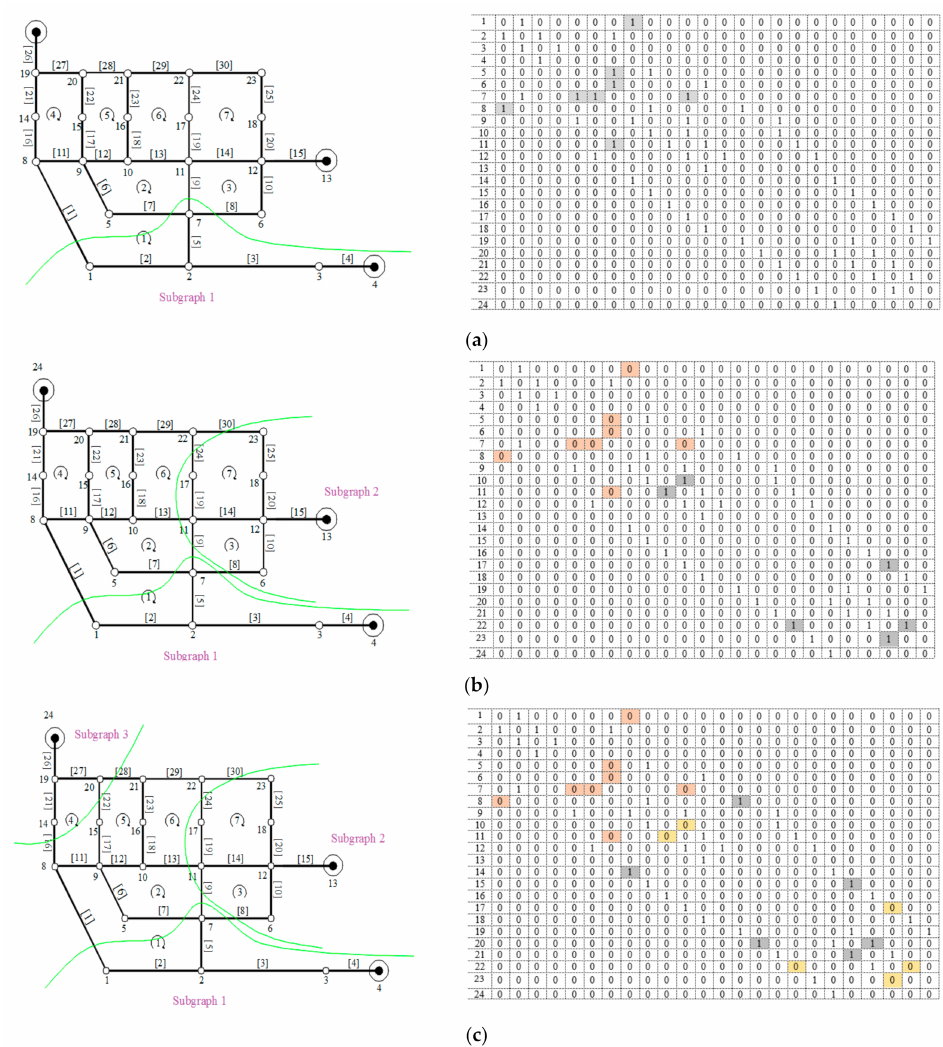
Figure 3. Finding the assigned zone for each outlet: ( a ) finding the assigned zone for the first root (node 4); ( b ) finding the assigned zone for the second root (node 13); ( c ) finding the assigned zone for the last root (node